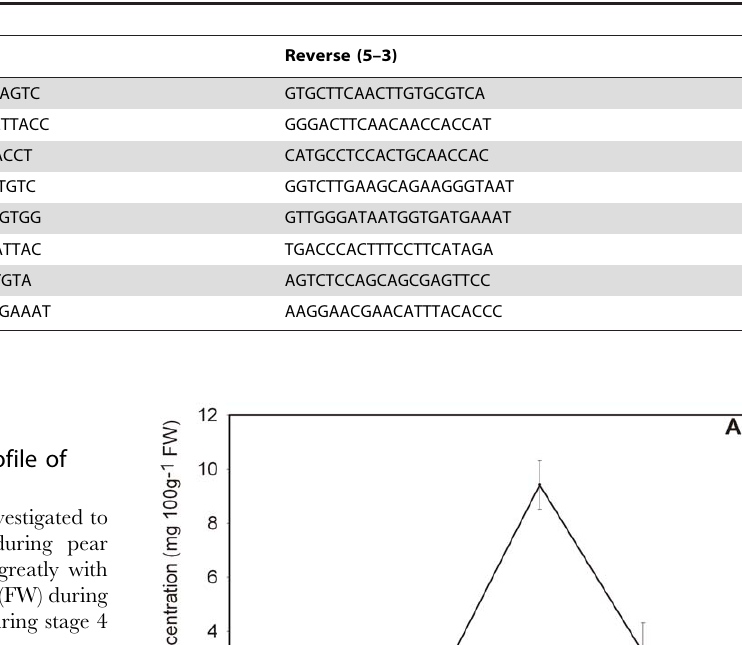
Table 1. Primers used for real-time qPCR analysis in Wujiuxiang pear.